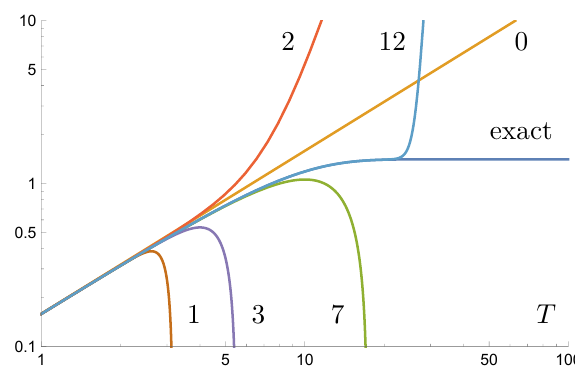
Figure 4 . The τ -scaling limit of the sum over genus g wormholes in the Airy model (A.2) up to g = g max (numbers shown) with e S 0 = 10 and β = 1 / 2 . This series converges to the